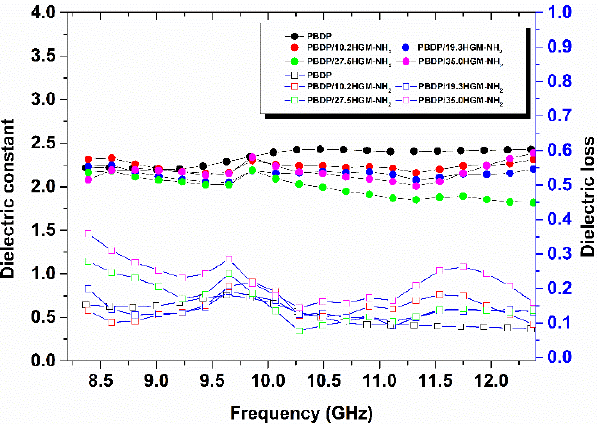
Figure 6. Dielectric properties as a function of frequency for neat, PBDP/HGM-NH 2 composites.